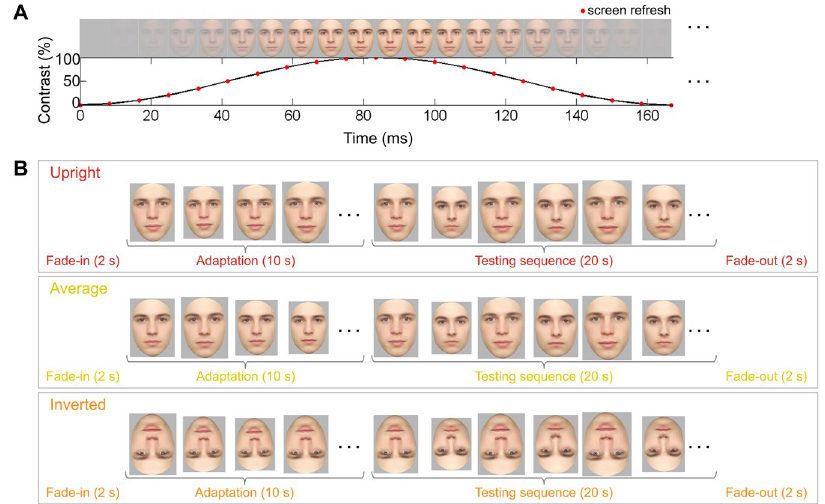
Figure 1. ( A ) Stimuli were presented through a gradual increase and decrease of contrast at each screen refresh frame, following a sinusoidal modulation of image contrast. Given a 120 Hz monitor (i.e., a screen refresh every 8.333 ms) and a 6 Hz stimulus presentation rate (i.e., 166.7 ms per stimulus cycle), each image was presented over 20 contrast steps (166.7 ms/8.333 ms), as illustrated. ( B ) The sequence structure of the three